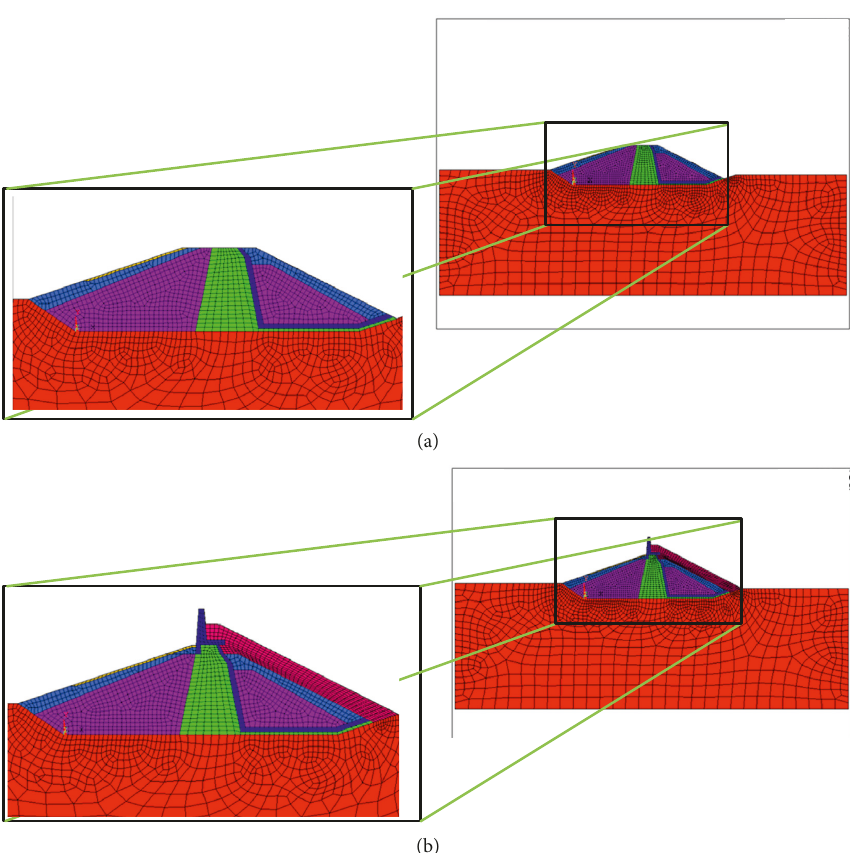
Figure 8: Finite element mesh of dam foundation and earthfill embankment: (a) initial section and (b) final section.